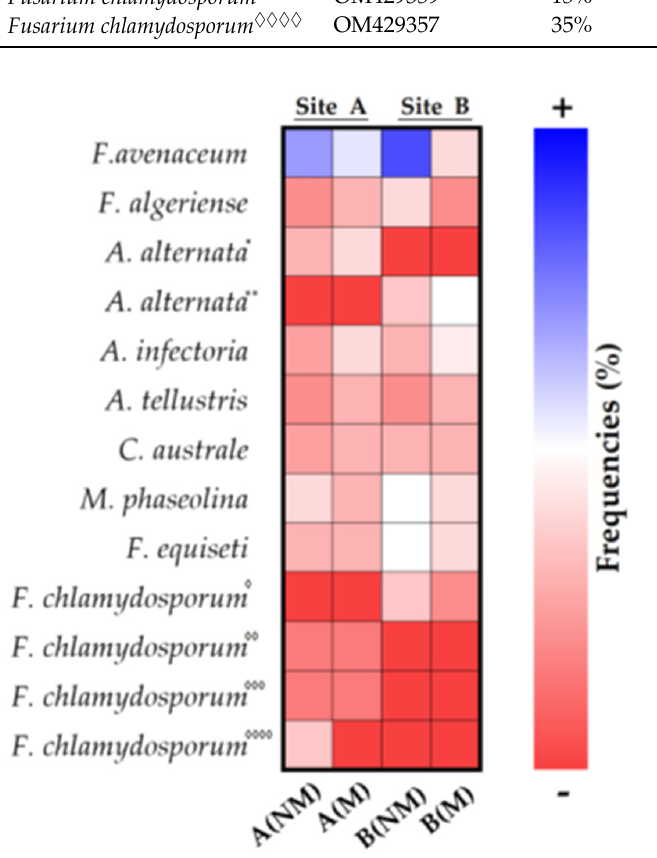
Figure 4. Heatmap of percentage frequency of endophytic fungi in the roots of Triticum durum . Different strains are indicated by superscript asterisks (“*”, “**”) and diamonds (“ ◊ ”, “ ◊◊ ”, “ ◊◊◊ ” and “ ◊◊◊◊ ”).